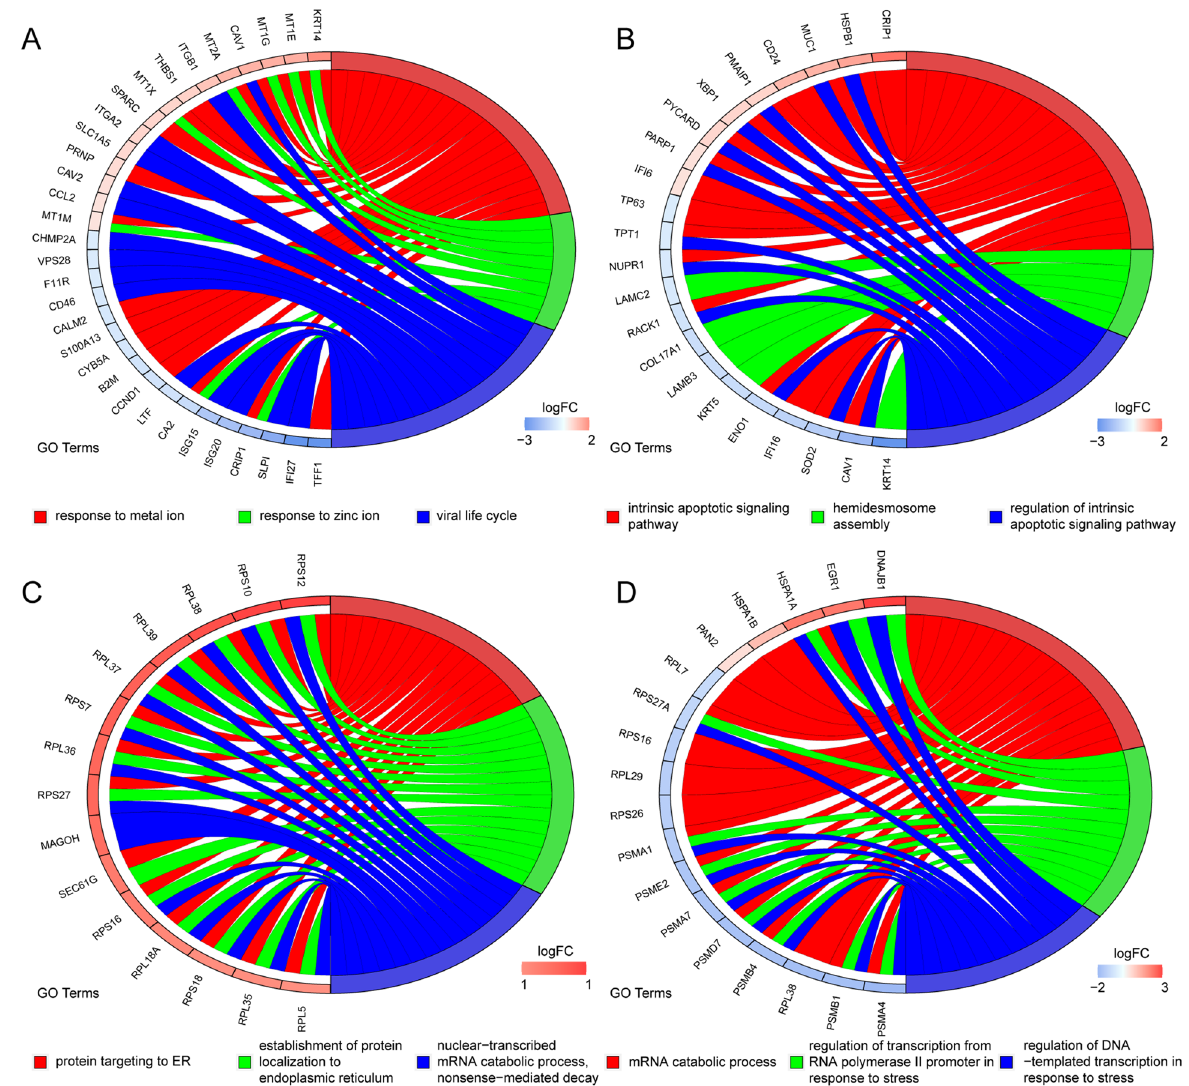
Figure 8. Gene markers and functional analysis of each invasive breast cancer (IBC) cell cluster. The chord plots reveal the highly related functions and genes assigned to IBC cell cluster 0 ( A ), cluster 1 ( B ), cluster 2 ( C ) and cluster 3 ( D )